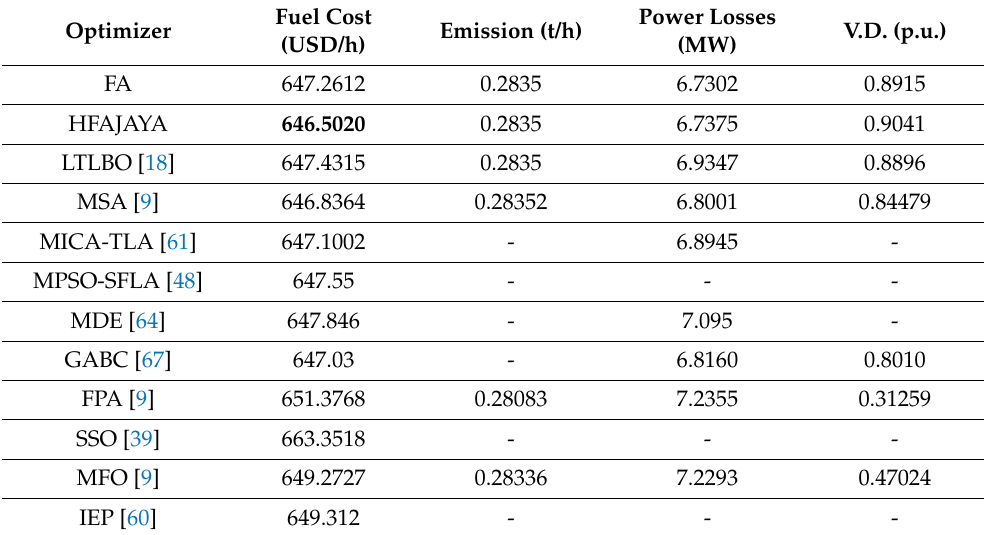
Table 4. The obtained optimal results in the current works for Case 2.